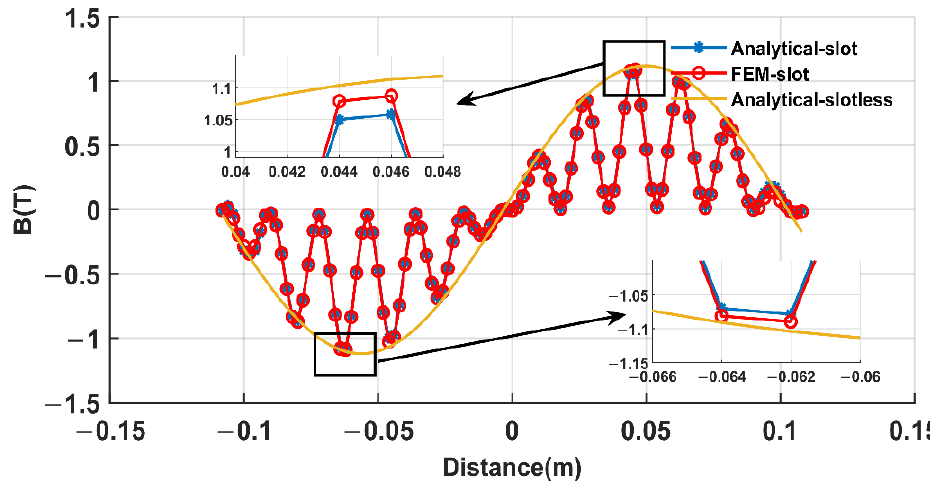
Table 4. Comparison of the three methods. Method